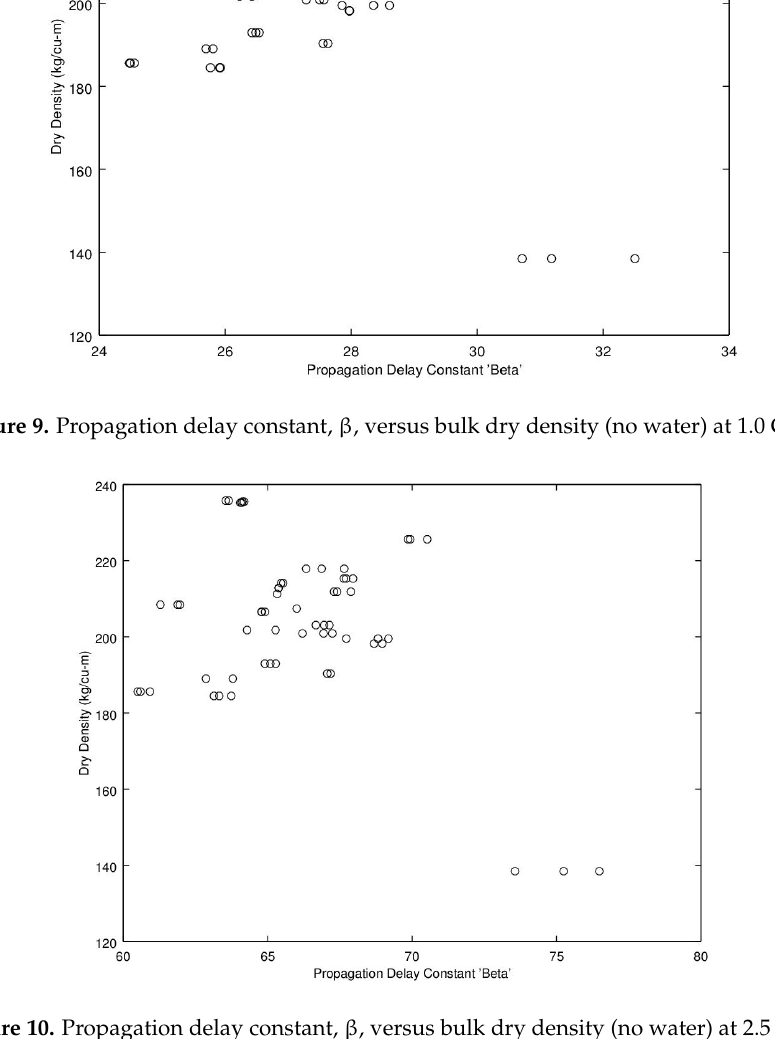
Figure 10. Propagation delay constant, β , versus bulk dry density (no water) at 2.5 GHz.